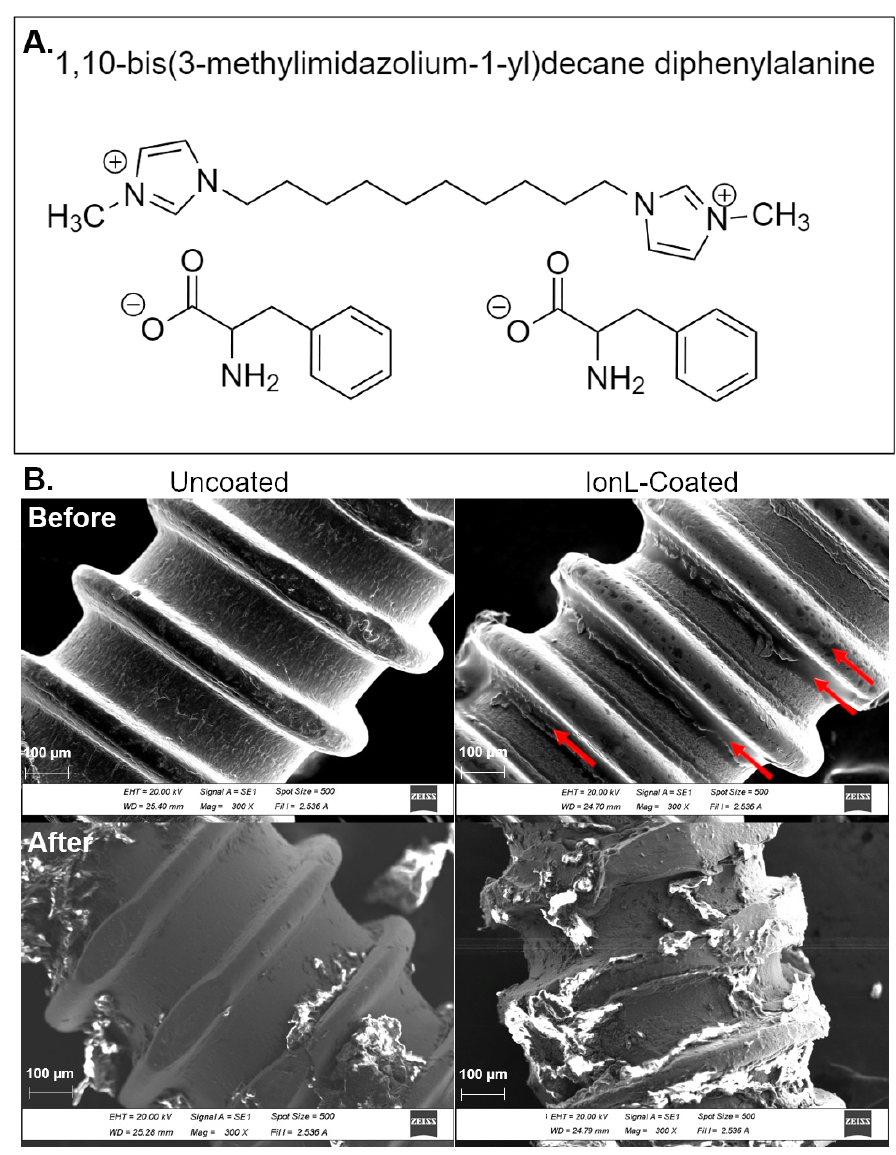
Figure 1. ( A ) Chemical structure of IonL ‐ Phe. ( B ) SEM of uncoated and IonL ‐ Phe ‐ coated screws used as implants in this study before and after insertion into the edentulous alveolar crest. Arrows indicate areas where IonL aggregates on the screw